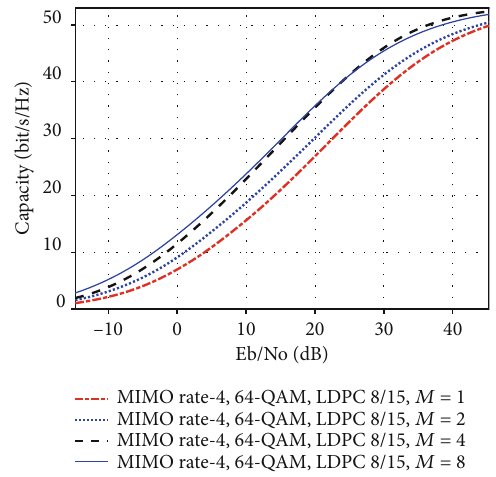
Figure 5: The BER performance against Eb/No for MIMO rate-2 using the modulation scheme of 256-QAM and the FFT size of 16K for various transmitter antennas of M = 1 , 2, 4, and 8.